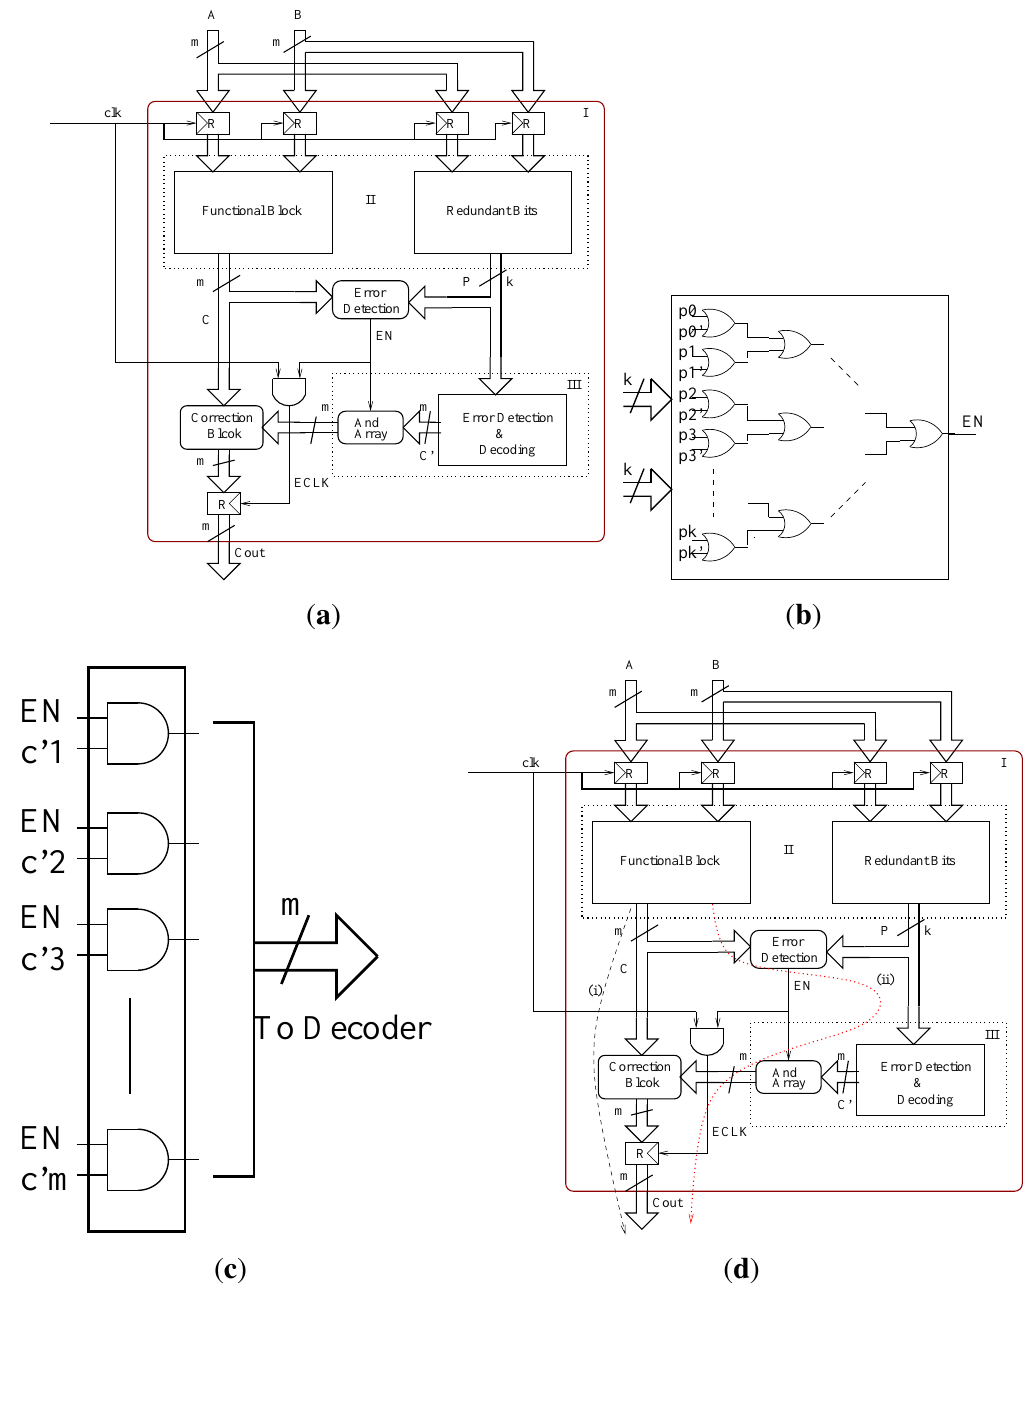
Figure 5. The Proposed Radiation Hardened Architecture and Architectural Components with Dynamic Error Detection and Correction Technique. ( a ) The Proposed Architecture of a Dynamically Error Correctable GF ECC Circuit; ( b ) Error detection block; ( c ) AND array; ( d ) Critical Paths in New Proposed